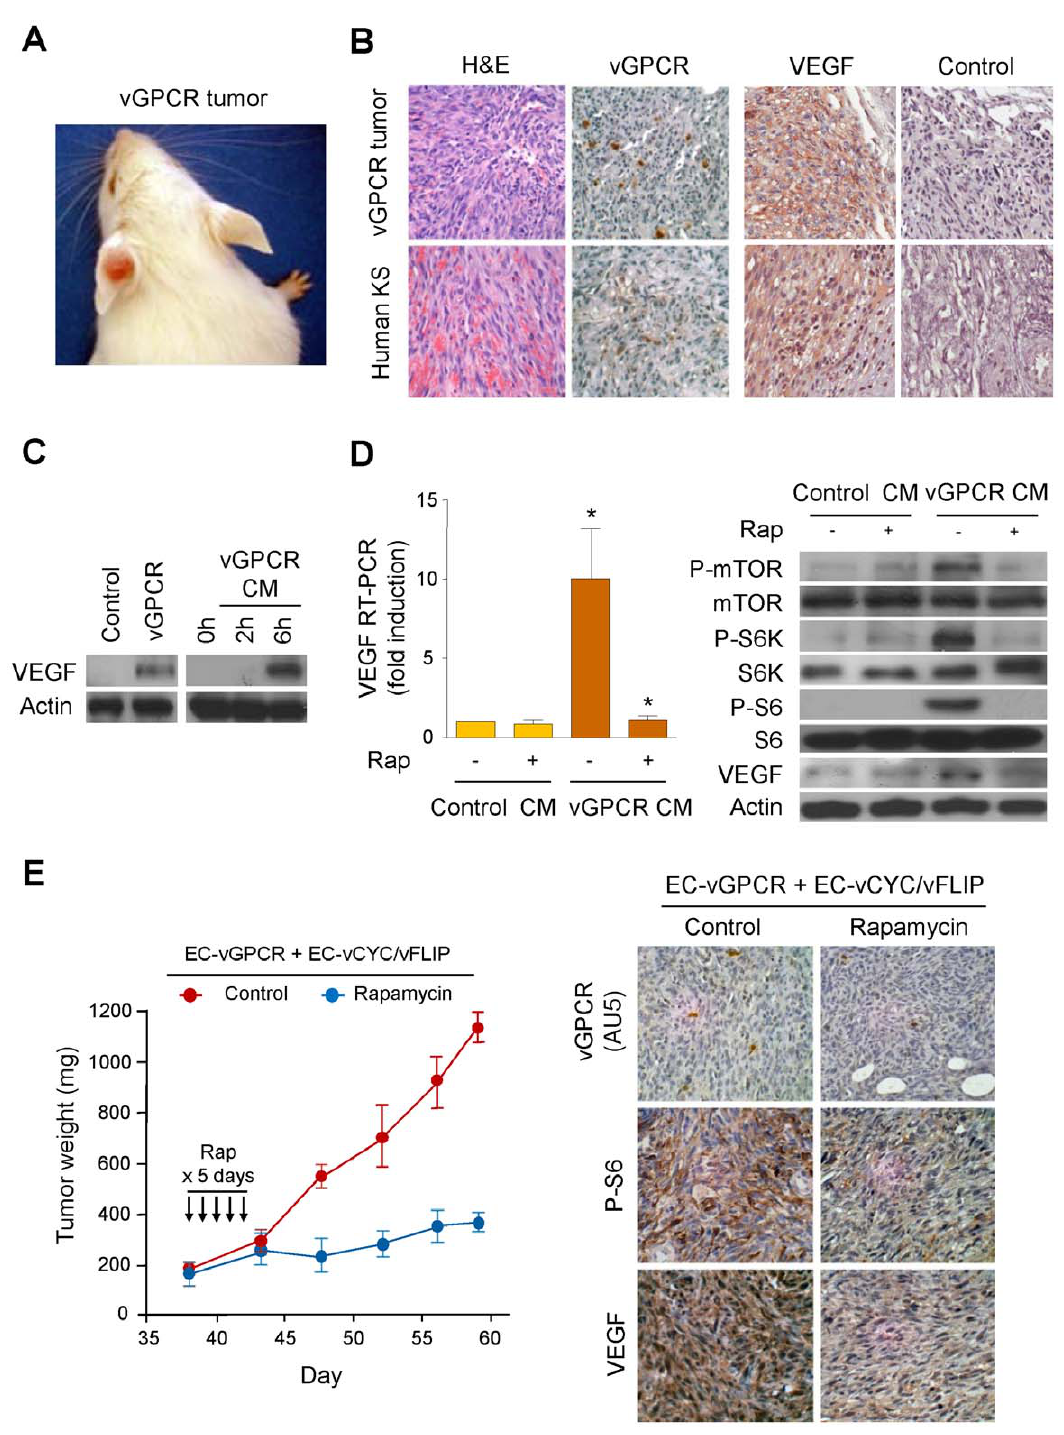
Figure 1. vGPCR activates VEGF expression through an mTOR-dependent paracrine mechanism. (A) KS-like lesion developed upon retroviral transduction of vGPCR in TIE2 -tva mice (vGPCR tumor), as described in Materials and Methods. (B) H&E and immunohistochemical stainings of vGPCR tumor and human KS, using antibodies against vGPCR, VEGF or an isotype-matched control antibody. (C) Upregulation of VEGF in HMEC1s transfected with Tet REV TA and pBIG AU5 vGPCR and treated with doxycycline (vGPCR), respect to untreated cells (Control). VEGF upregulation in HMEC1 exposed for 2 h or 6 h to supernatants collected from vGPCR-expressing cells (vGPCR CM). (D) Supernatants from vGPCR-expressing cells (vGPCR CM) or control cells (Control CM) were used to treat HMEC1 in the presence or absence of Rapamycin (50 nM). RT-PCR and Western blot analysis were used to determine levels of VEGF mRNA and protein, respectively. (E) EC-vGPCR (10%) were mixed with EC- vCYC/vFLIP (90%), and injected into athymic nu/nu mice for allograft formation. Tumor weight curves, and immunohistochemical detection in tumor tissue of (AU5-tagged) vGPCR-expressing cells, phosphorylated ribosomal S6 protein or VEGF, upon treatment with (10 mg/kg) Rapamycin of vehicle (Control), are shown.